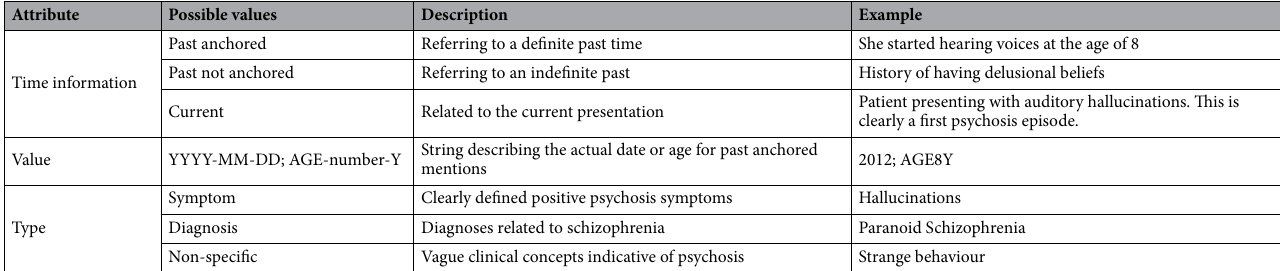
Table 5. Annotation schema for identifying mentions of psychosis